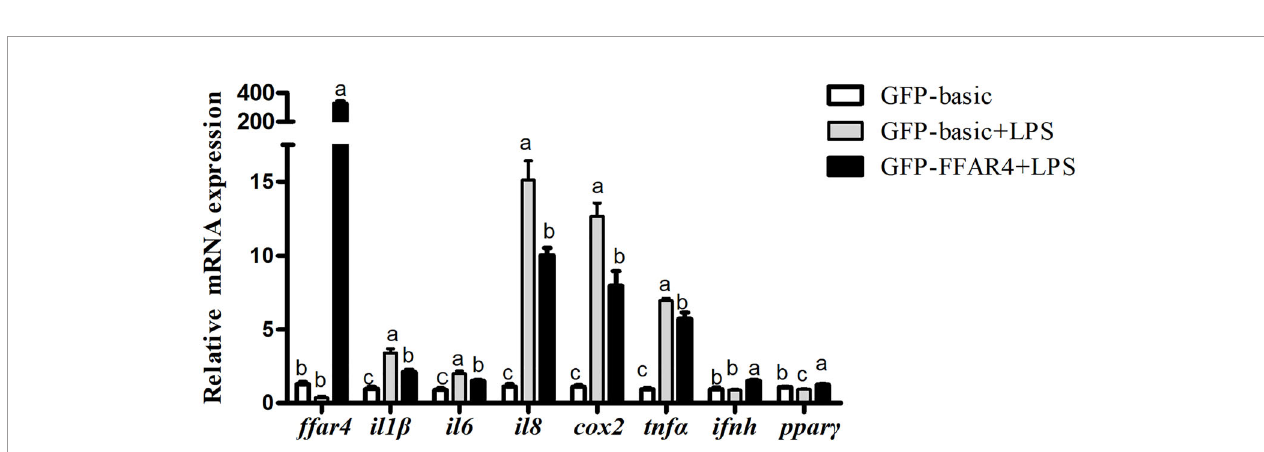
FIGURE 3 | Effects of FFAR4 antagonist AH7614 on the expression of in fl ammation related genes induced by LPS in macrophages of large yellow croaker. Data were shown as mean ± S.E.M. (n = 4). For each gene, values in bars bearing the same letters were not signi fi cantly different among treatments ( P >